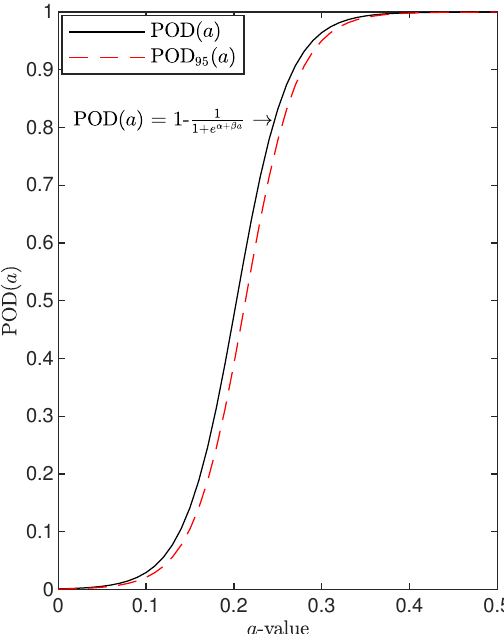
Figure 2. Probability of detection curve versus flaw size, calculated using the hit/miss procedure with the function model and estimation of